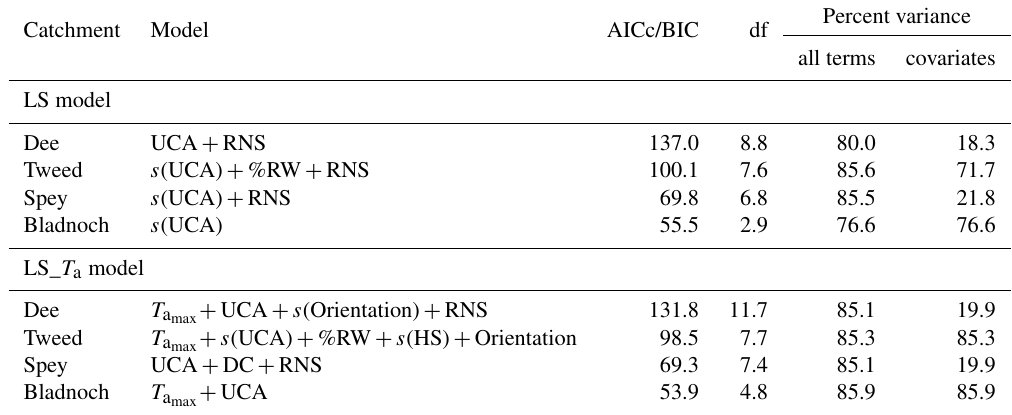
Table 2. LS model and LS_ T a model for each catchment, with the percent variance explained by the model (all terms) and the same model but with the RNS omitted